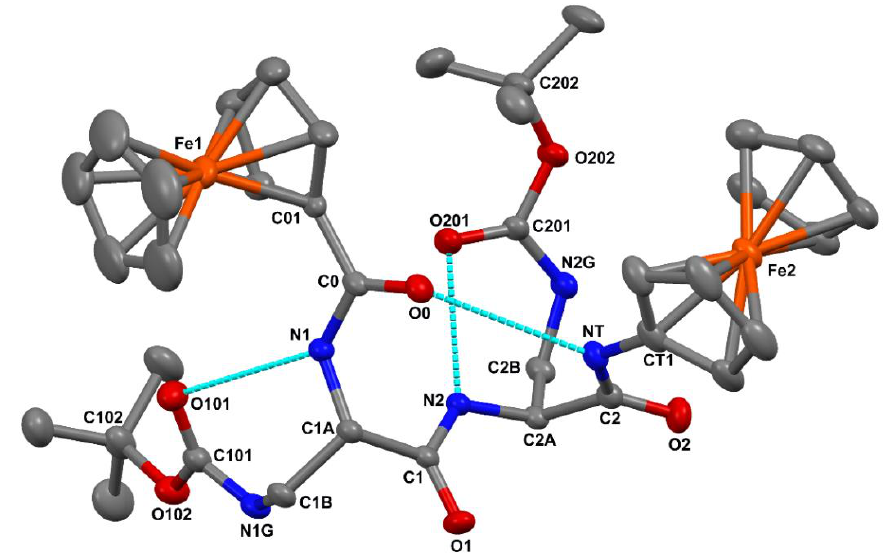
Figure 2. X-ray diffraction structure of 2 . H-atoms and the disordered, co-crystallized CDCl 3 molecule are omitted for clarity. Anisotropic displacement ellipsoids are drawn at the 30% probability level. The three intramolecular N–H . . . O=C H-bonds are indicated by dashed lines.